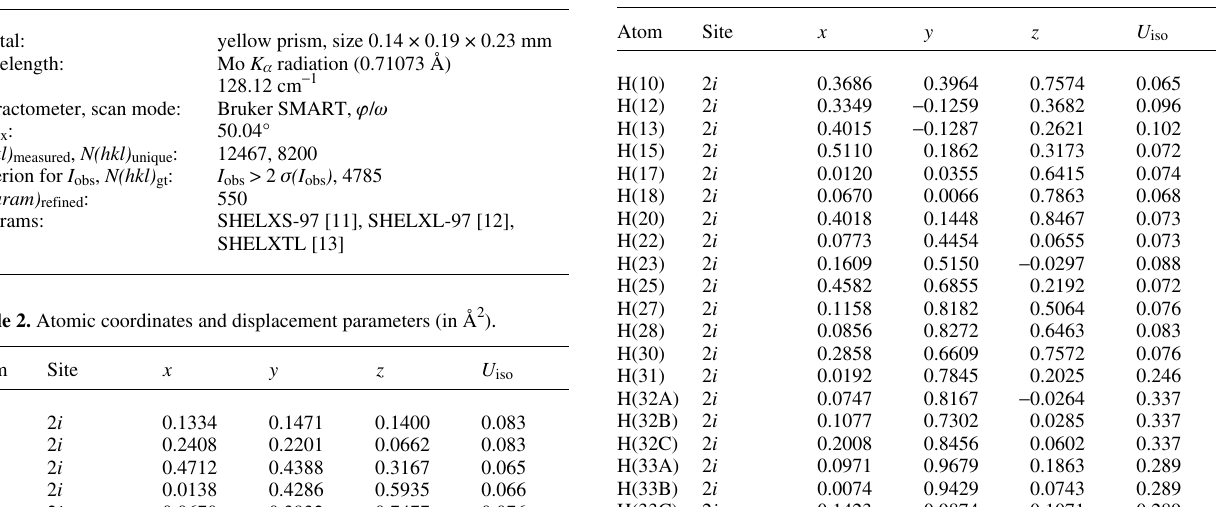
Table 1. Data collection and